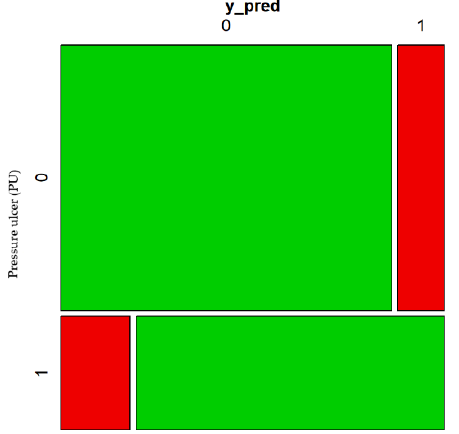
Figure 6. Confusion matrix 2 of the estimated model. In addition, the area under the ROC curve is of 91.68% which confirms the good discrimination of the model to identify PU risk using only these two subscales. Figure 7 shows the ROC curve supporting this